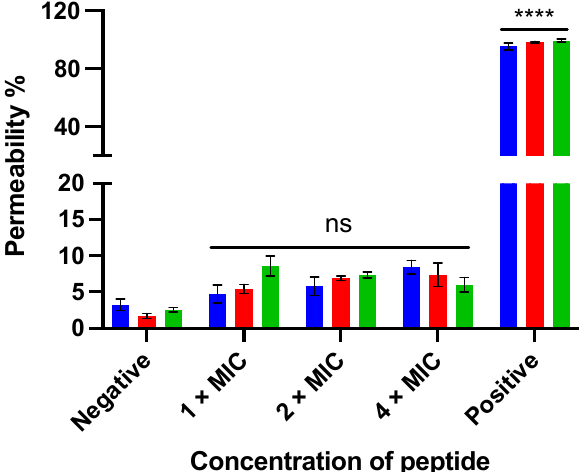
Figure 6. The membrane permeabilizing effect of kunitzin-OV 2 (blue), TAT-KOV 2 (red), and TAT- F9-KOV 2 (green) against E. coli at the concentration of 1 × MIC, 2 × MIC, and 4 × MIC. The bacterial treated with 70% isopropanol and 0.85% NaCl solution (5% LB) was used as the positive and negative controls, respectively. The permeability percentage was obtained by comparing it to the fluorescent intensity of positive control. The error bar represents the SEM of nine replications in three experiments and the significant difference results were calculated by comparing various treatments with the negative control (**** p < 0.0001, ns: No significance).